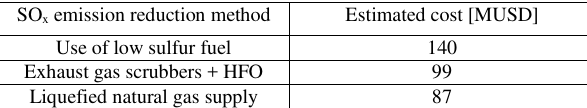
Table 2. Compare the cost of individual solutions SO x emission reduction method Estimated cost [MUSD] Use of low sulfur fuel 140 Exhaust gas scrubbers + HFO